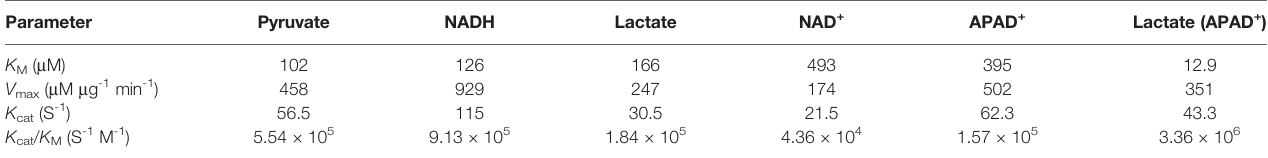
TABLE 2 | Kinetic parameters of BoLDH on different substrates and cofactors. Parameter Pyruvate NADH